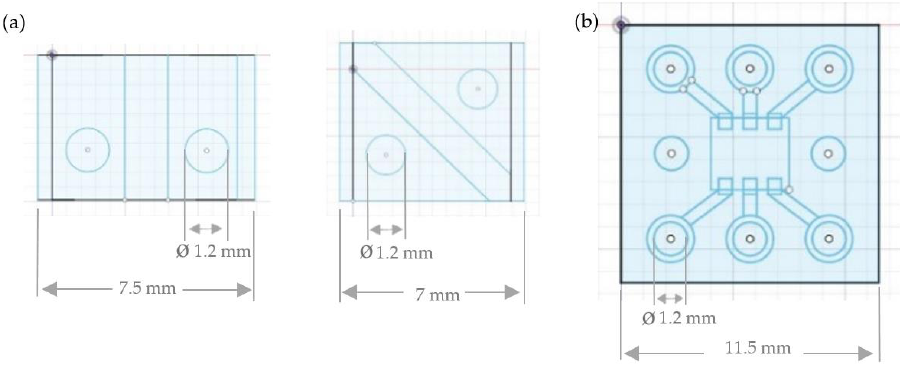
Figure 11. Single-layer sequin designs for ( a ) LED sequins designs and ( b ) RGB